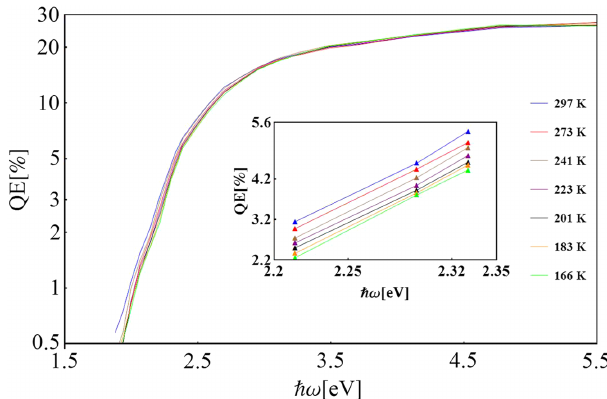
FIG. 2. The spectral response of K 2 CsSb cathode as it was cooled from room temperature to 166 K. The inset is the zoomed- in change in QE due to cooling; it dropped as the temperature was lowered.